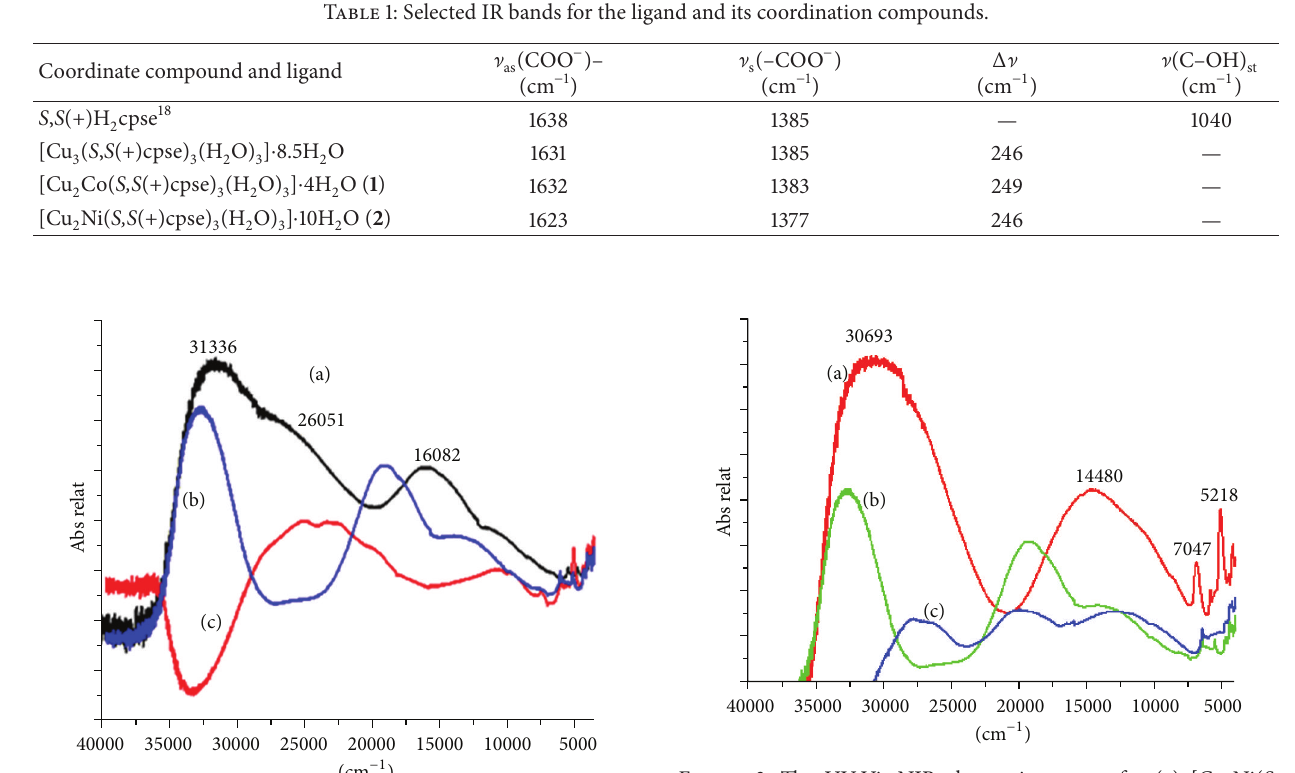
Figure 3: The UV-Vis-NIR electronic spectra for (a) [Cu 2 Ni( S, S (+)cpse) 3 (H 2 O) 3 ] ⋅ 10H 2 O ( 2 ), (b) [Ni( S,S (+)cps) 2 ] ⋅ 2H 2 O [17]